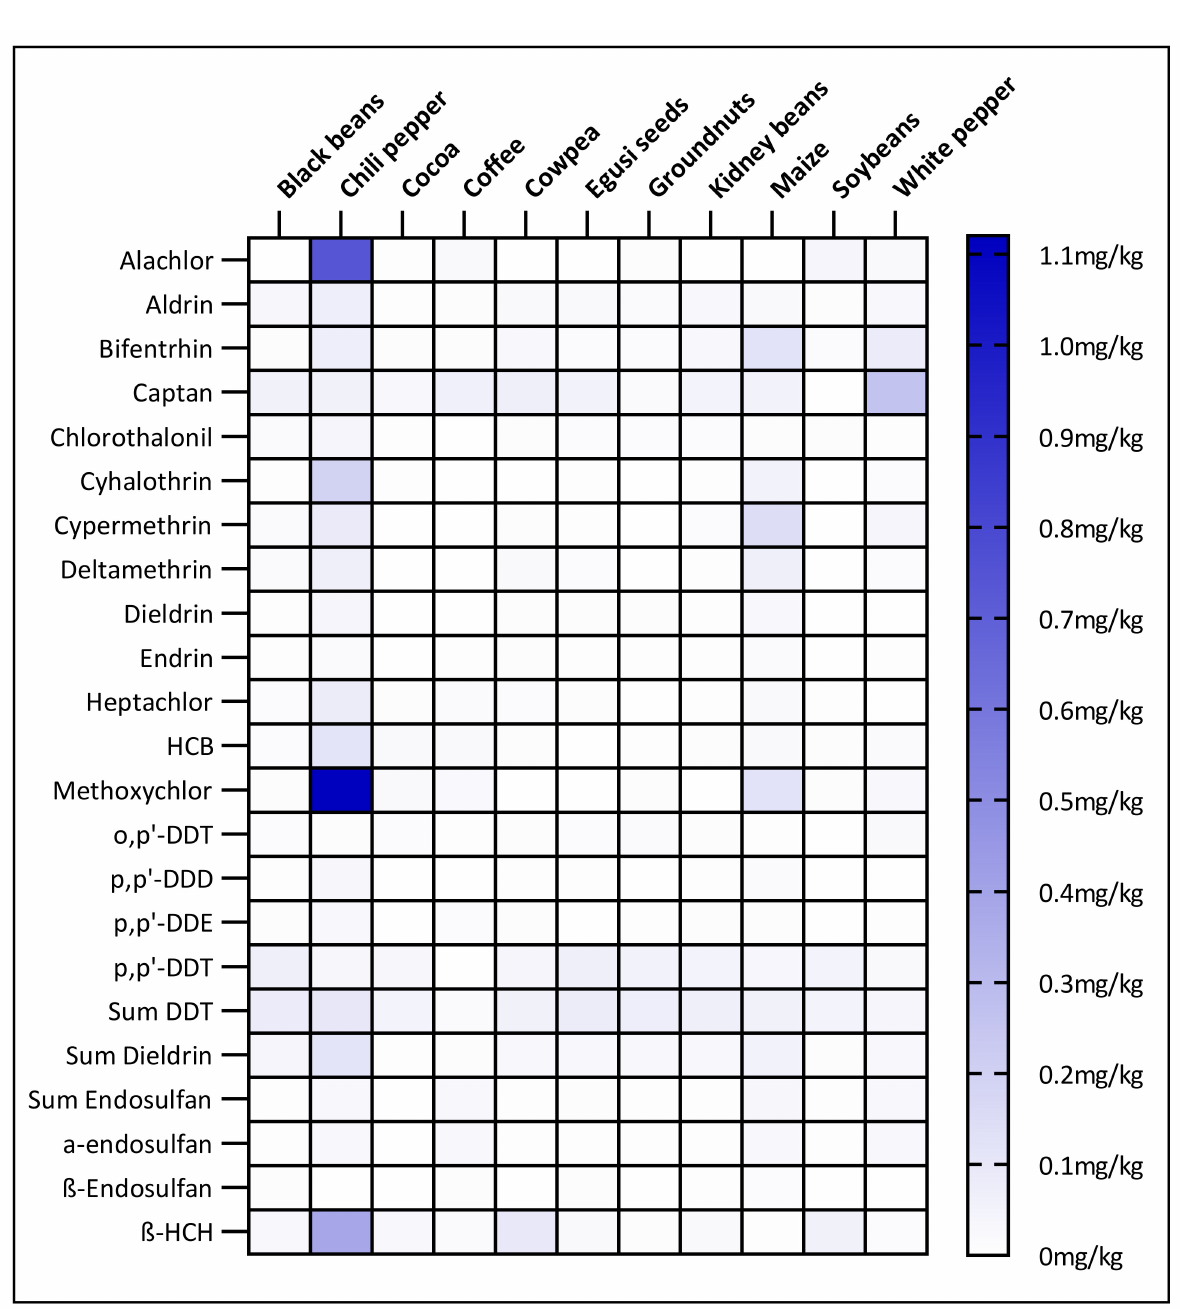
Figure 4. Average concentrations of halogenated pesticide residues in 11 food items from the 3 largest cities of Cameroon. HCB = hexachlorobenzene, HCH = hexachlorocyclohexane, DEE = dichlorodiphenyldichloroethylene, DDD = dichlorodiphenyldichloroethane, DDT = dichlorodiphenyltrichloroethane. Σ DDT = p,p’-DDT + op’-DDT + pp’-DDD + pp’-DDE. Σ dieldrin = aldrin + dieldrin. Σ endosulfan= α -endosulfan + β